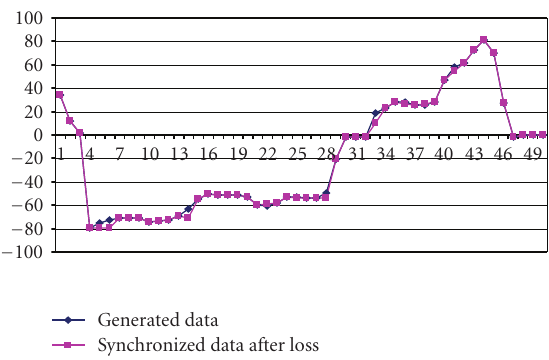
Figure 12: Comparison between generated data at server and synchronized data at client.